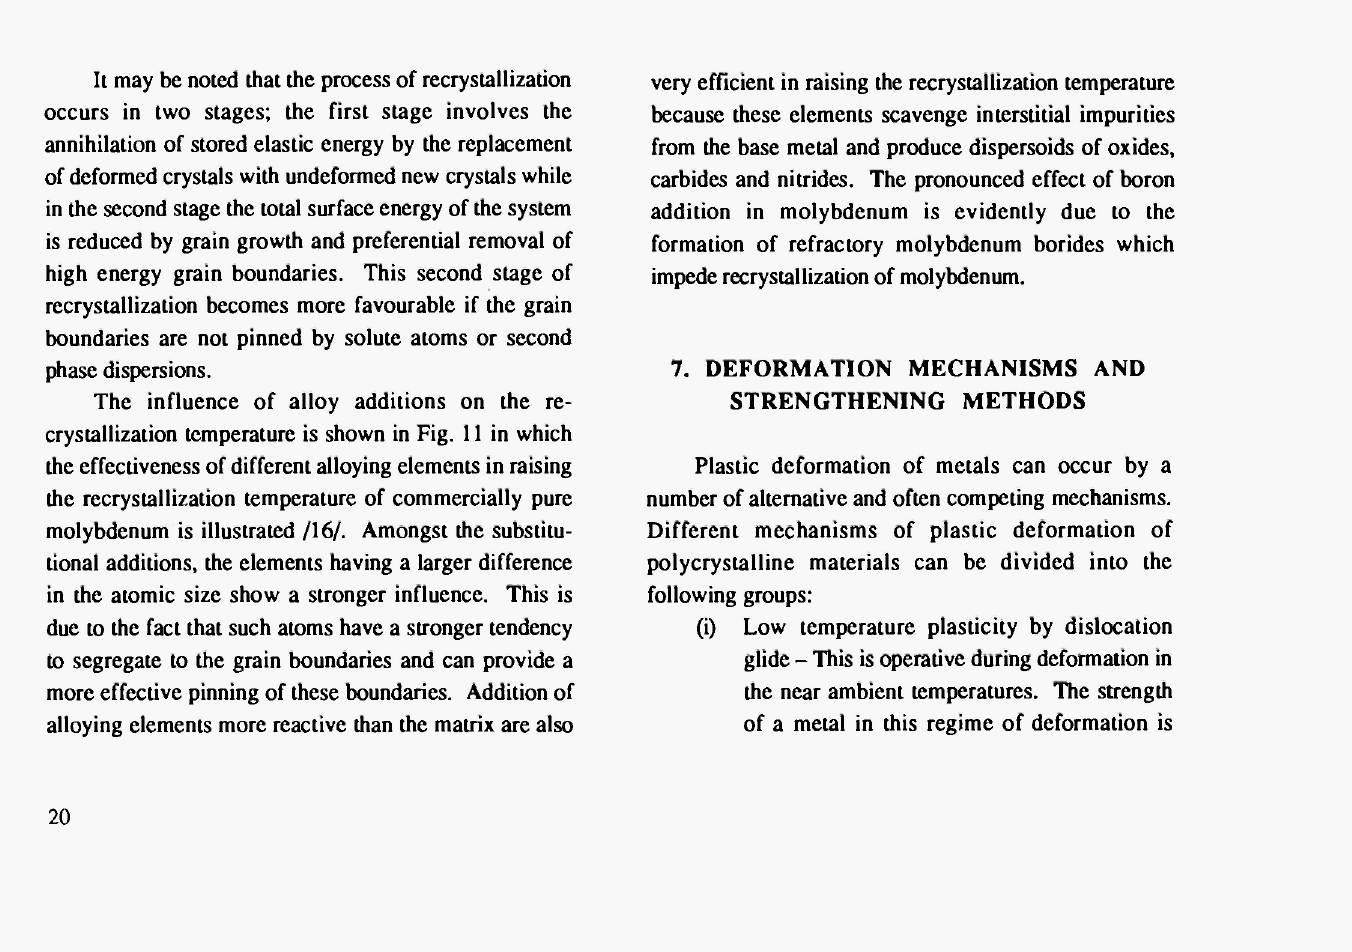
11: The influence of alloying addition on the recrystallization temperature of molybdenum alloys (from / I f